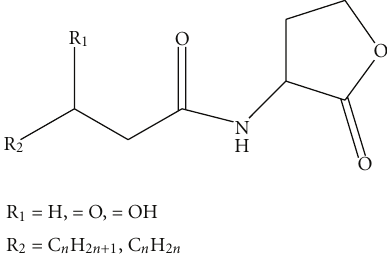
Scheme 1: General structure of bacterial N-acyl-homoserine lac-